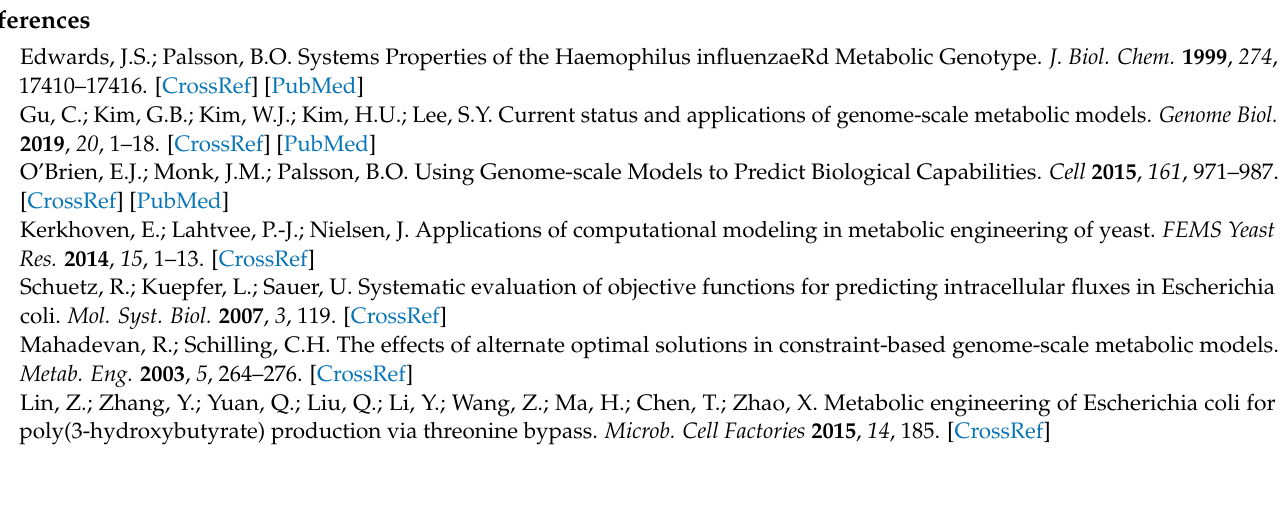
Figure S3: Flux comparison of ec i ML1515_ori and ec i ML1515_adj_round2. Table S1: The modified genes. Table S2: The corrected kinetic parameters. Table S3: The kinetic parameters. Table S4: Enzyme cost of energy metabolism in E. coli. Table S5: The maximum growth